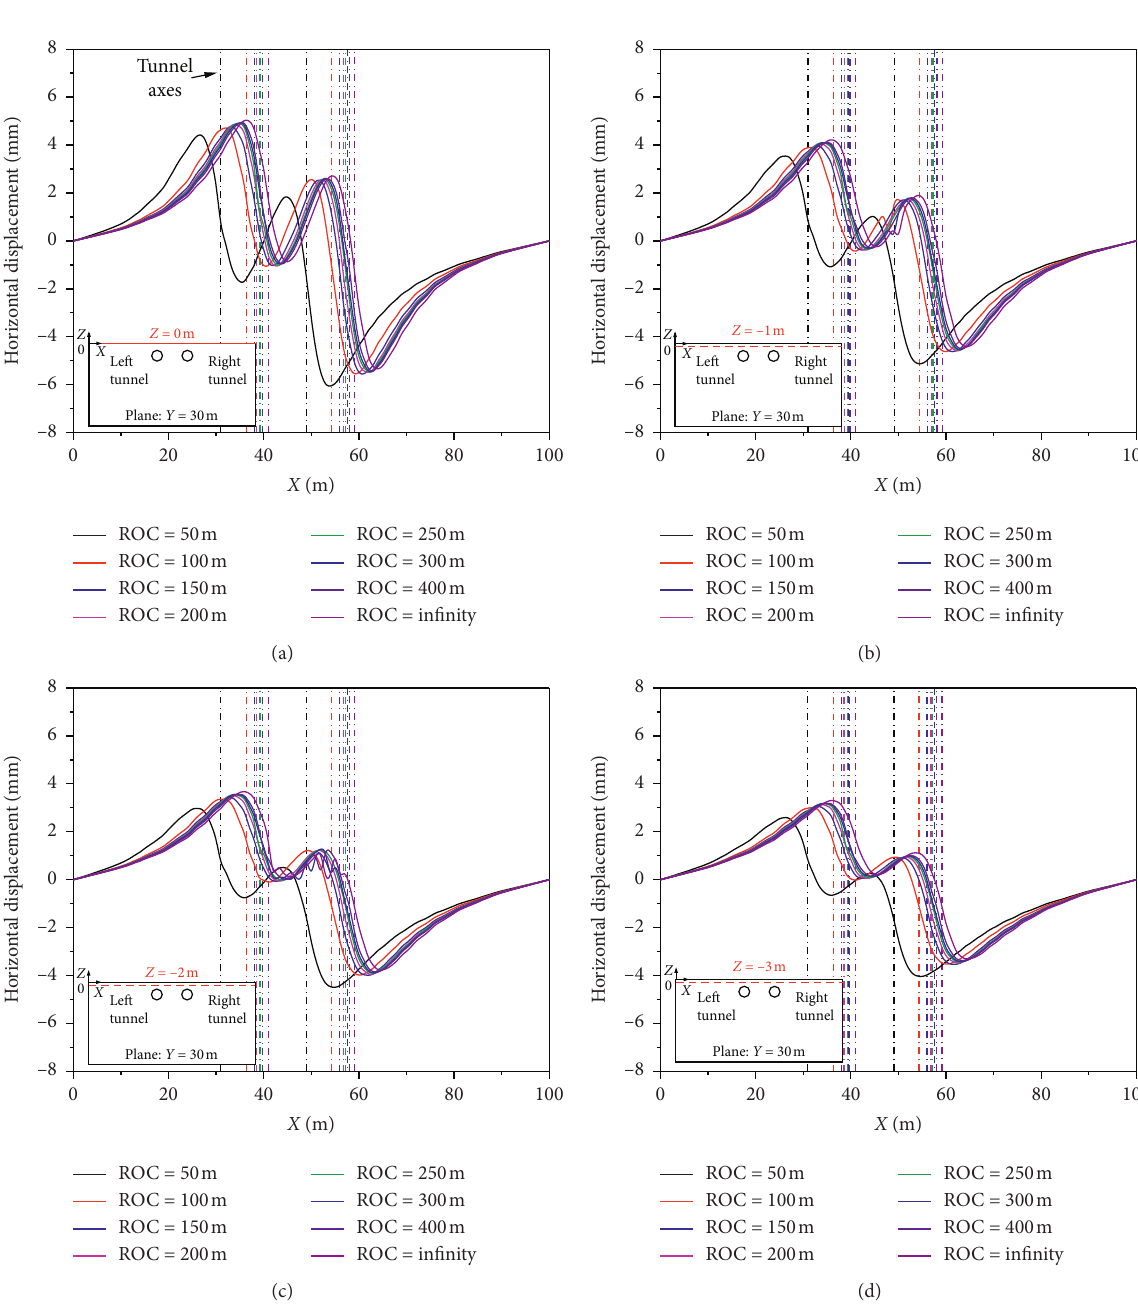
Figure 12: Tunnelling induced horizontal ground displacements at the final step along Y � 30m at different depths: (a) Z � 0 m, (b) Z �− 1m, (c) Z � − 2m, and (d) Z �−